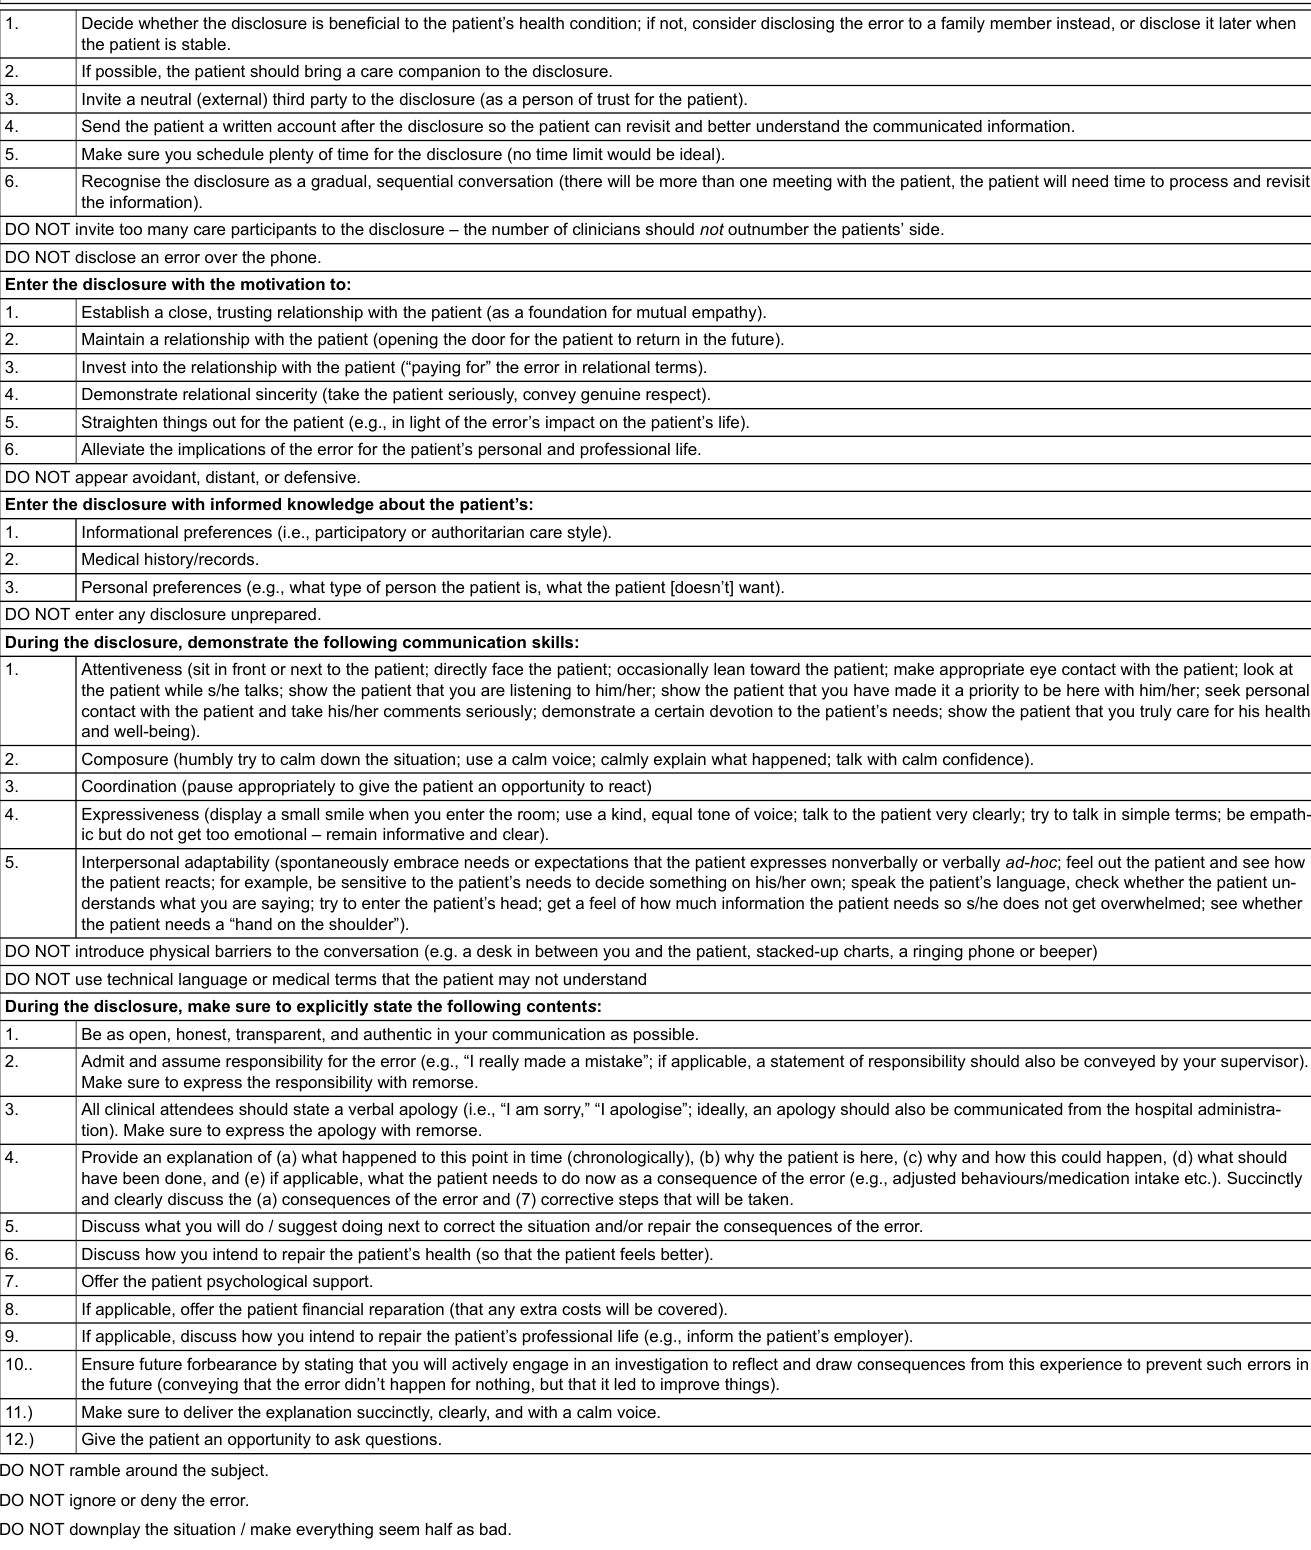
Table 5: Medical error disclosure competence (MEDC) training